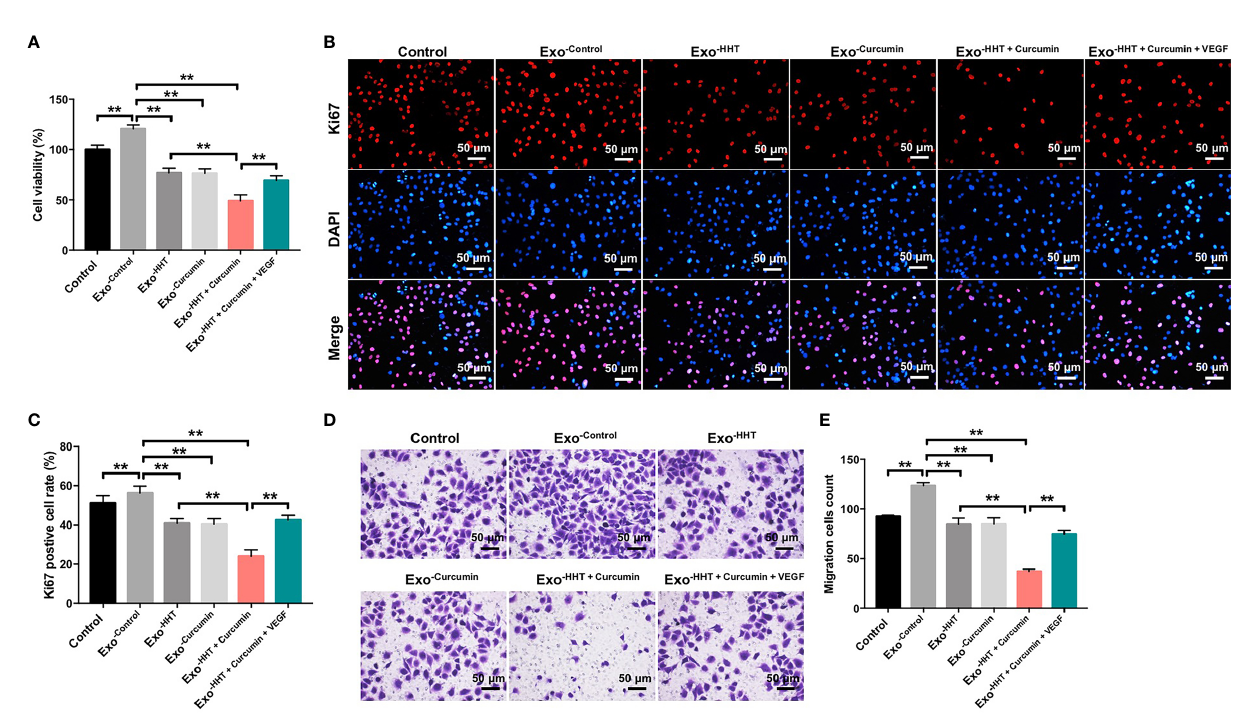
FIGURE 5 | Raji/combination exosomes inhibits proliferation and migration of HUVECs. HUVECs were co-cultured with exosomes obtained from Raji cells that were treated with HHT or/and curcumin or treated with HHT, curcumin and VEGF. (A) CCK-8 assay was used to detect cell viability. (B, C) Relative fl uorescence expression levels were quanti fi ed by Ki67 and DAPI staining. (D, E) Cell migration was detected by transwell migration assay. **P <